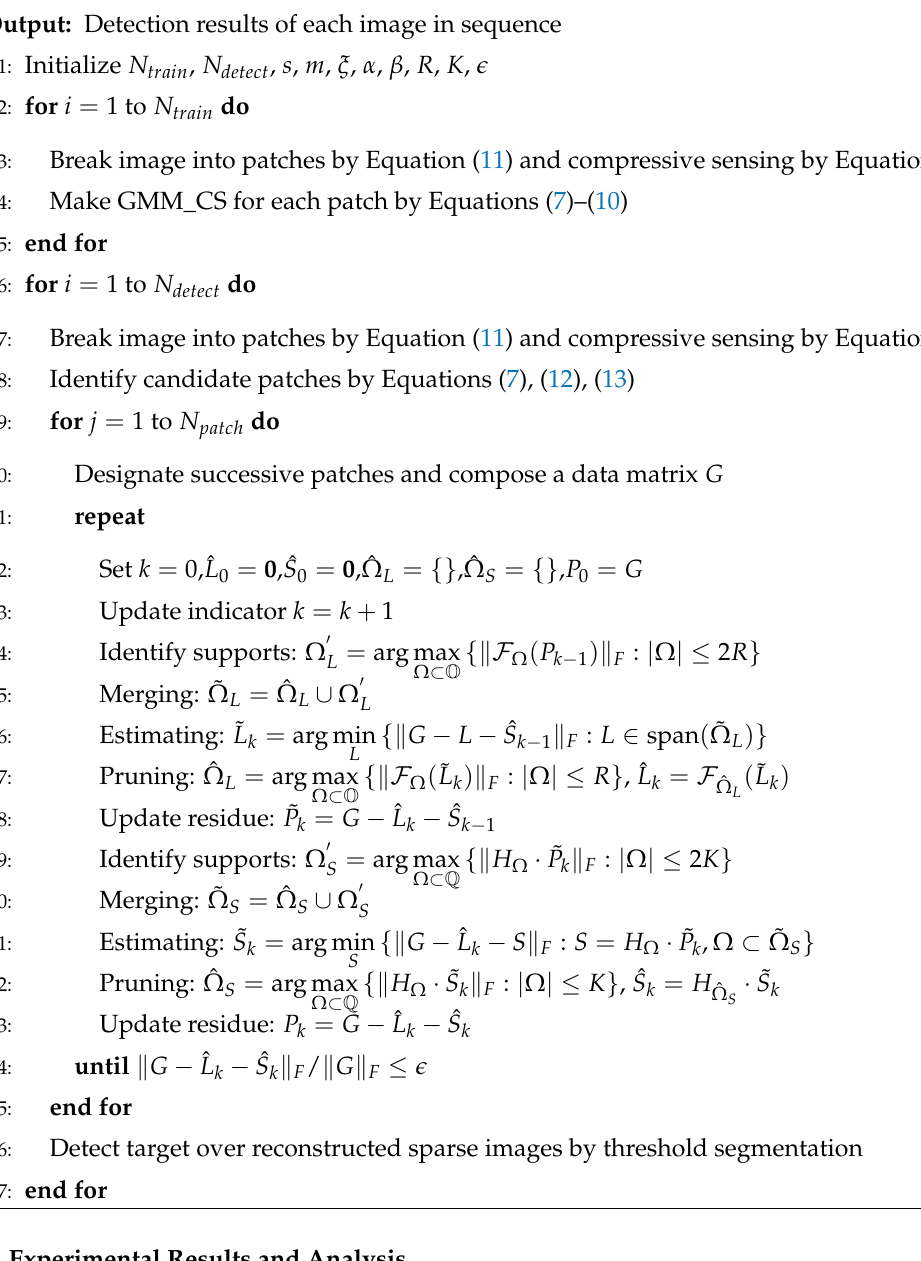
Algorithm 1 Approach to flying small target detection based on